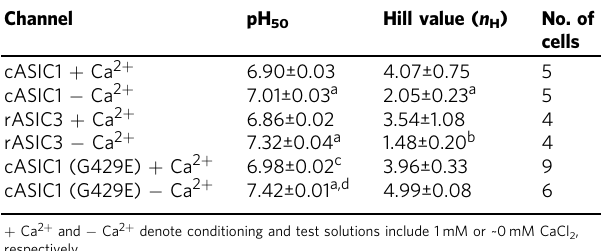
Table 2 Summary of the pH activation for cASIC1, rASIC3 and cASIC1 G429E in the absence and presence of Ca 2 + Channel